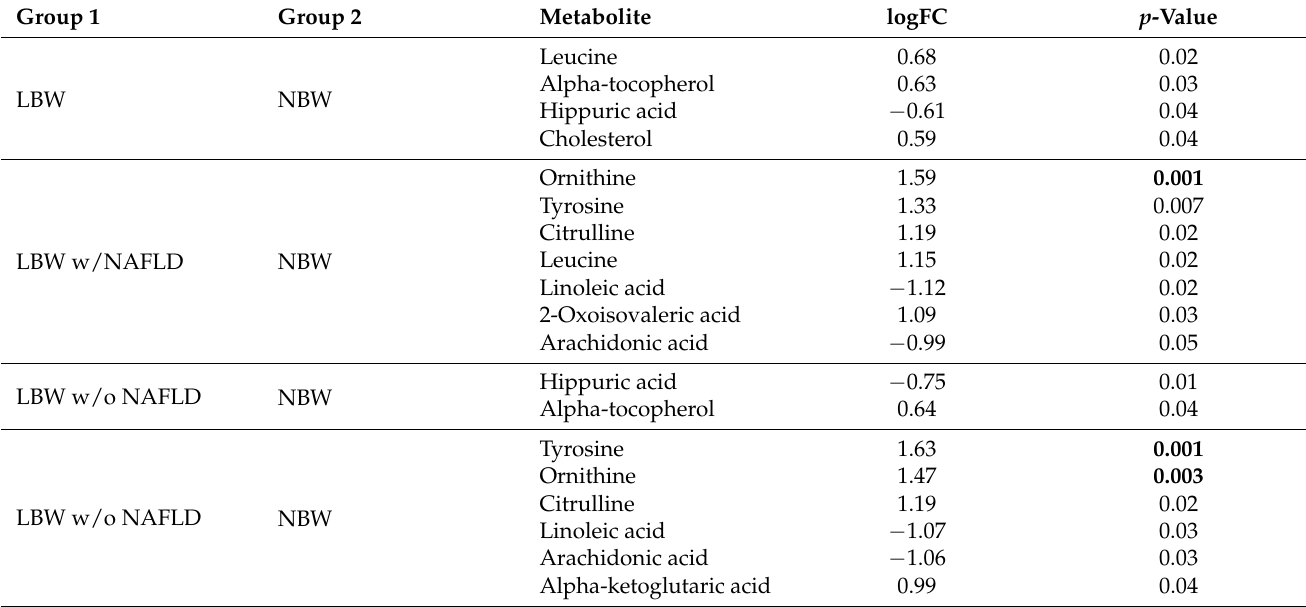
Table 2. Differentially abundant serum metabolites ( n = 11) denoted as log fold change (logFC) identified by four separate abundance analyses between groups ( p ≤ 0.05). P FDR ≤ 0.1 are marked in